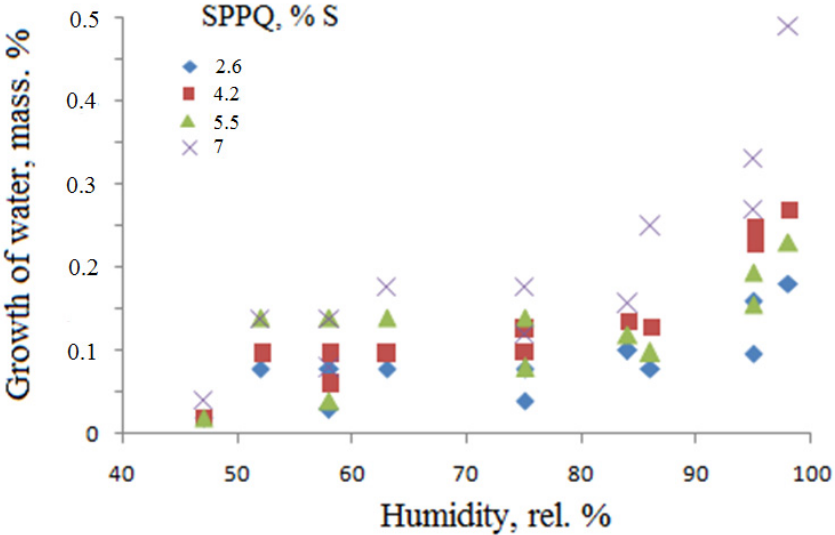
Figure 4. Water sorption of SPPQ films in humid air atmosphere, wt. %.